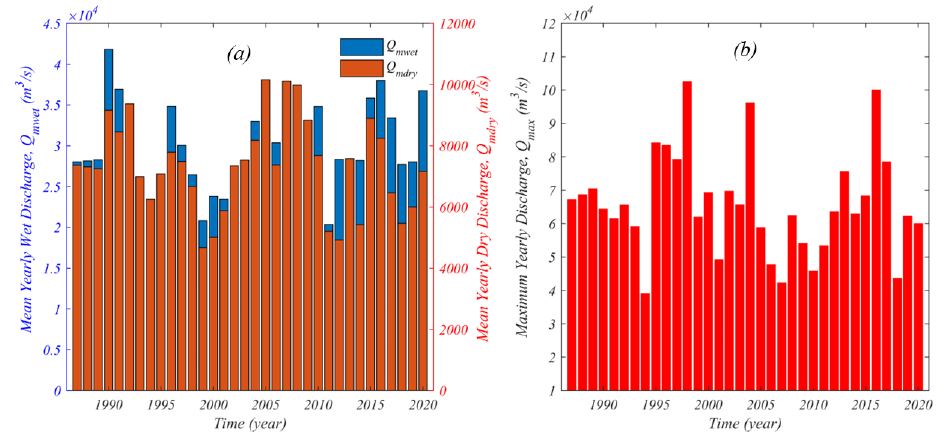
Figure 4. ( a ) Extracted mean yearly wet and dry discharge data and ( b ) Yearly maximum discharge data of the BR from 1987 to